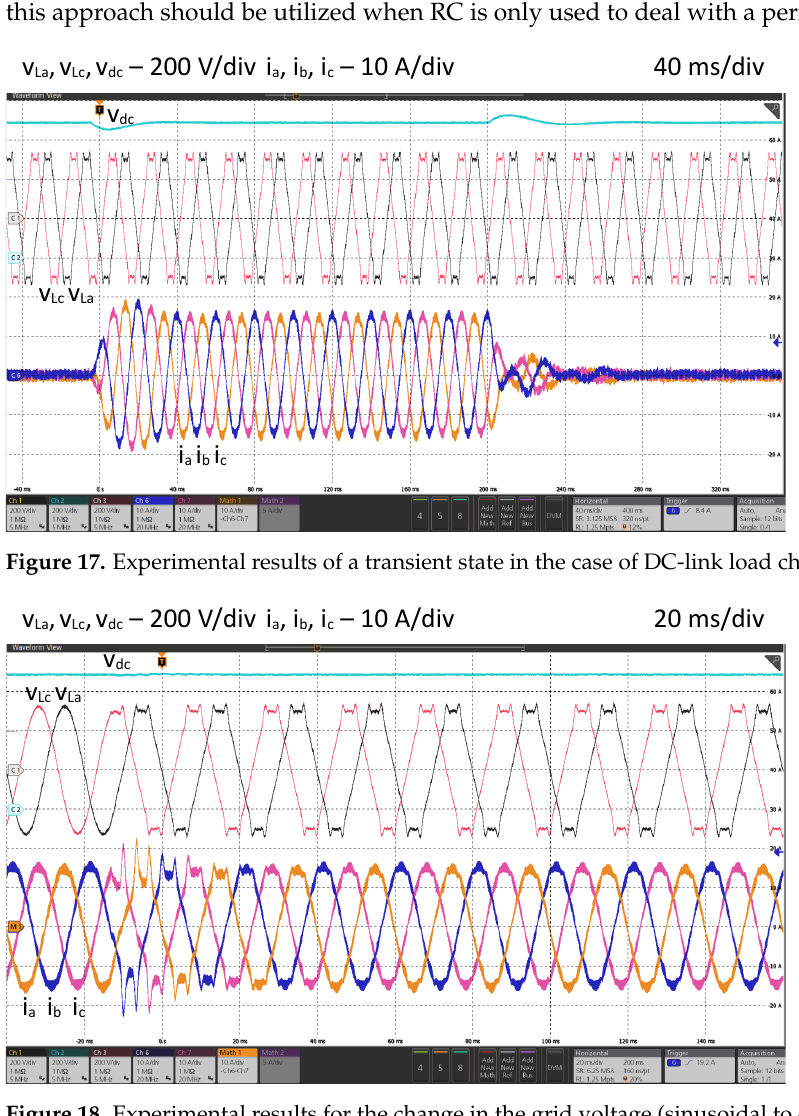
Figure 18. Experimental results for the change in the grid voltage (sinusoidal to distorted).